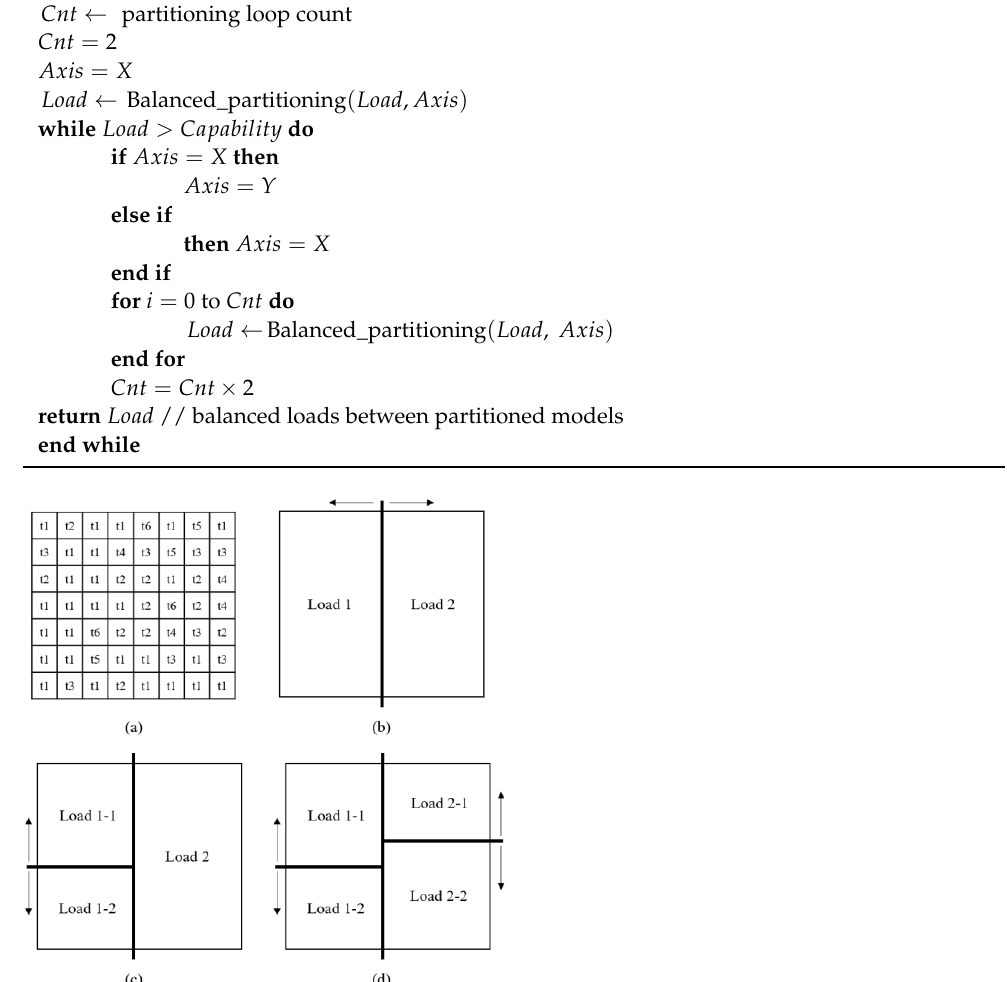
Figure 6. The simulation time comparison, in terms of balanced computing loads.